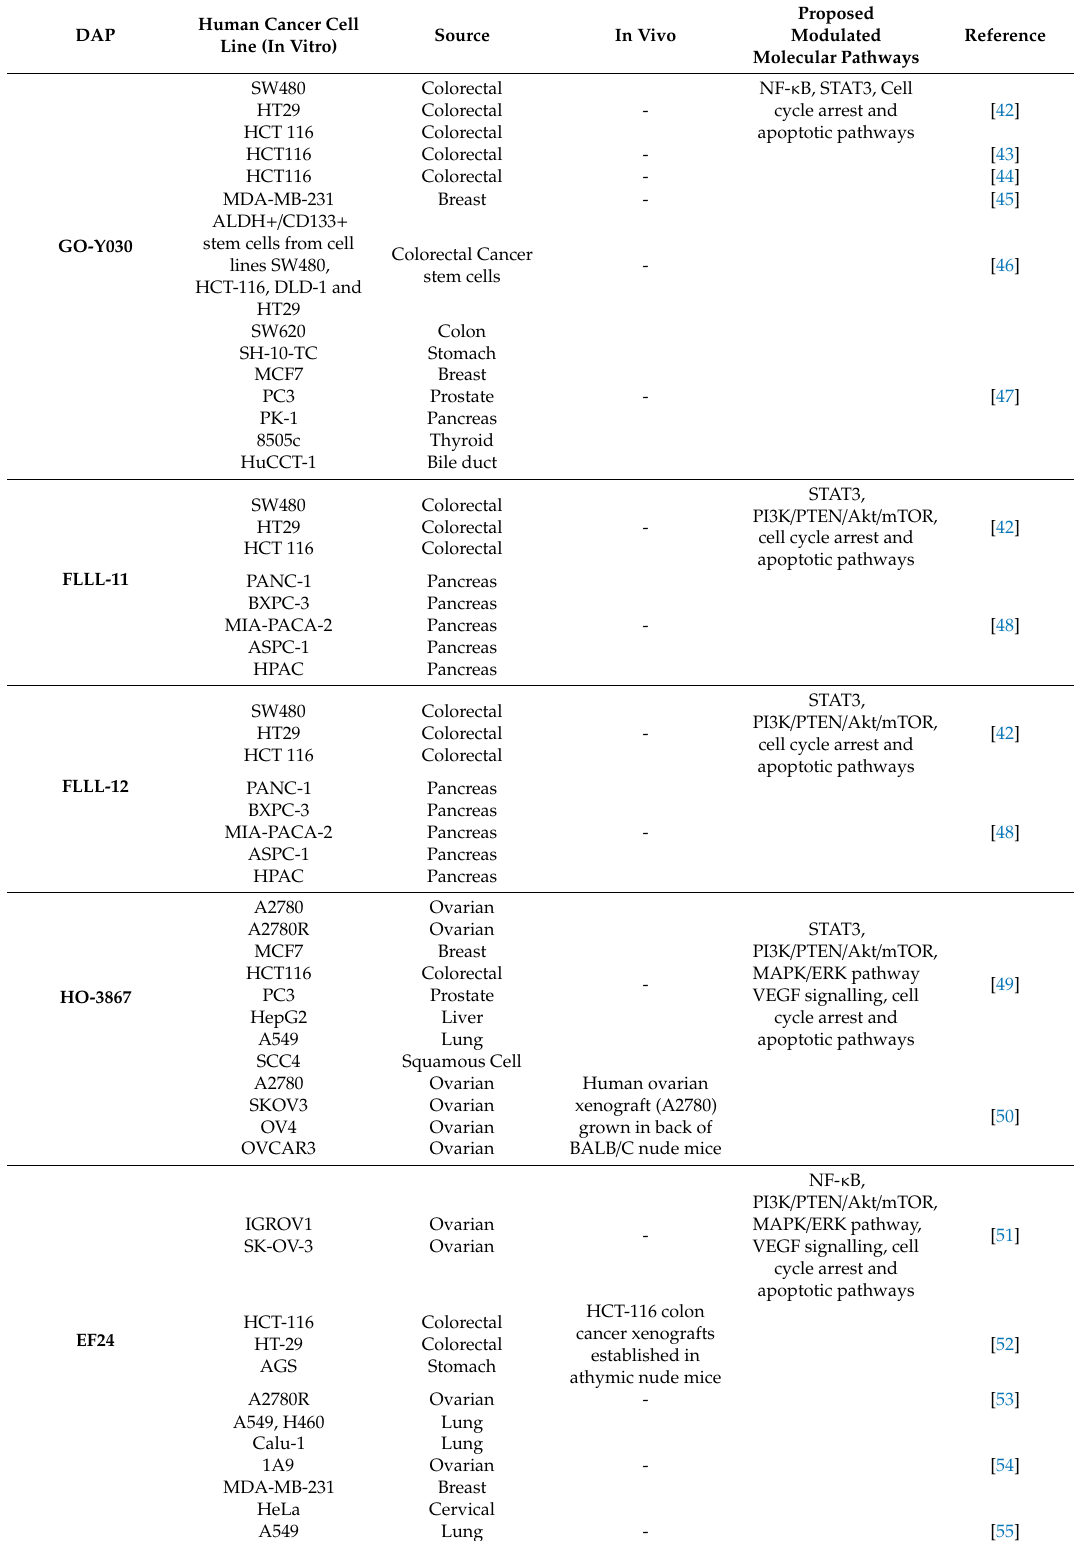
Table 1. Proposed molecular pathways modulated by diarylpentanoids (DAPs) in vivo and in vitro. Human Cancer Cell DAP Line (In